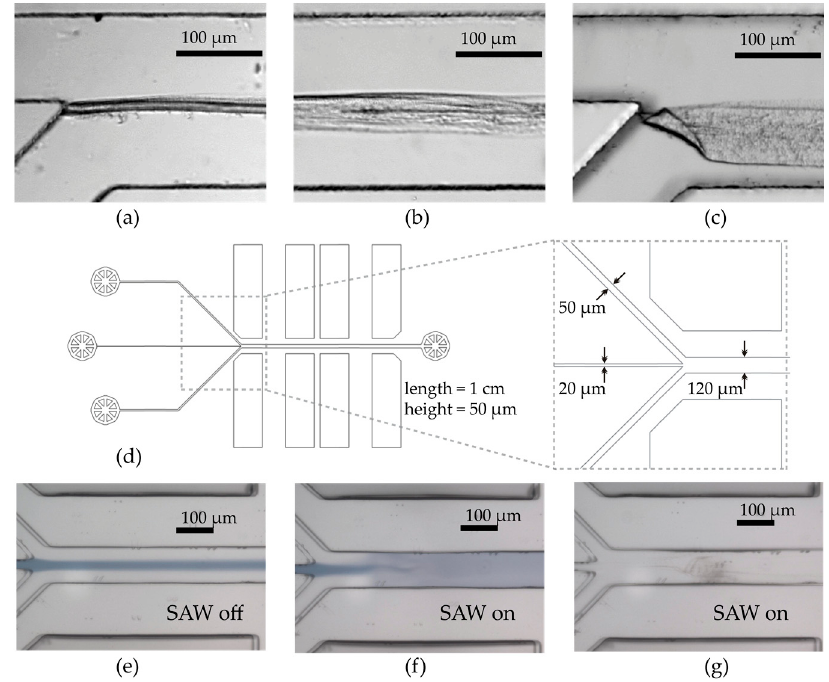
Figure 7. ( a ) Diffusive mixing of bPEI (upper inlet) and pDNA (lower inlet) in a Y-shaped microchannel leads to complex formation at the interface of the two fluids; ( b ) Broad layer about 10 mm downstream; ( c ) Complex layer after 24 h of incubation, i.e., without flow; ( d ) The design of the Y-shaped channel is modified to a 3-in-1 channel; ( e ) Using the 3-in-1 channel with a “protective” buffer layer (here blue) ensures the prevention of complex formation; ( f ) 3-in-1 channel with applied SAW; ( g ) Mixing of bPEI and pDNA in a 3-in-1 channel: no unwanted complex formation occurs, only some minor precipitation at the channel bottom appears without disturbing the particle formation.